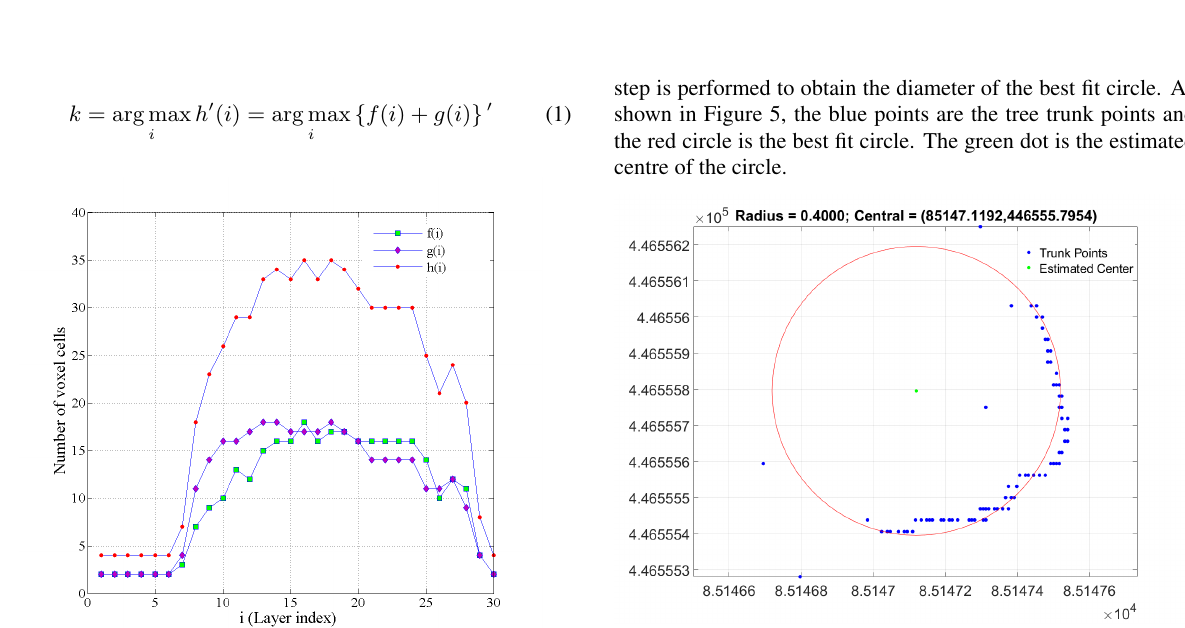
Figure 3: Number of cells in each layer.